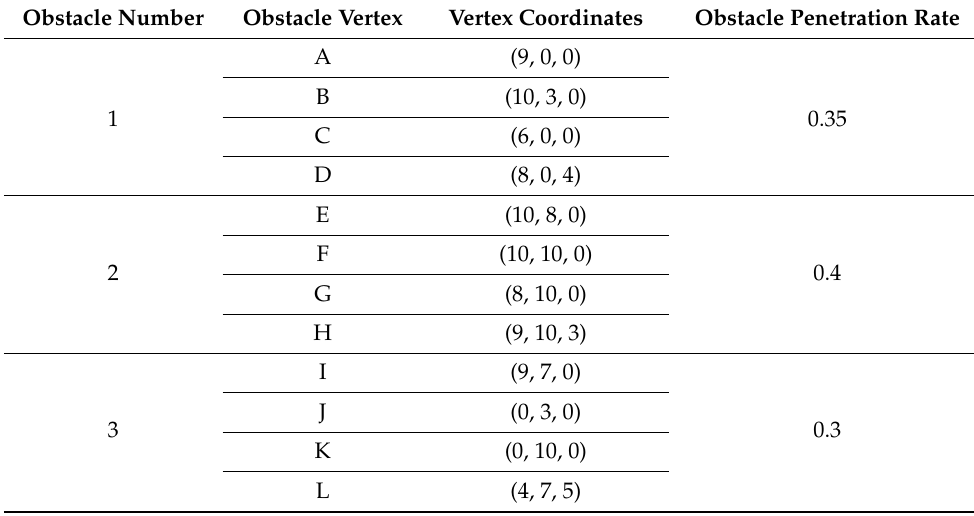
Table 4. Relevant information of obstacles.